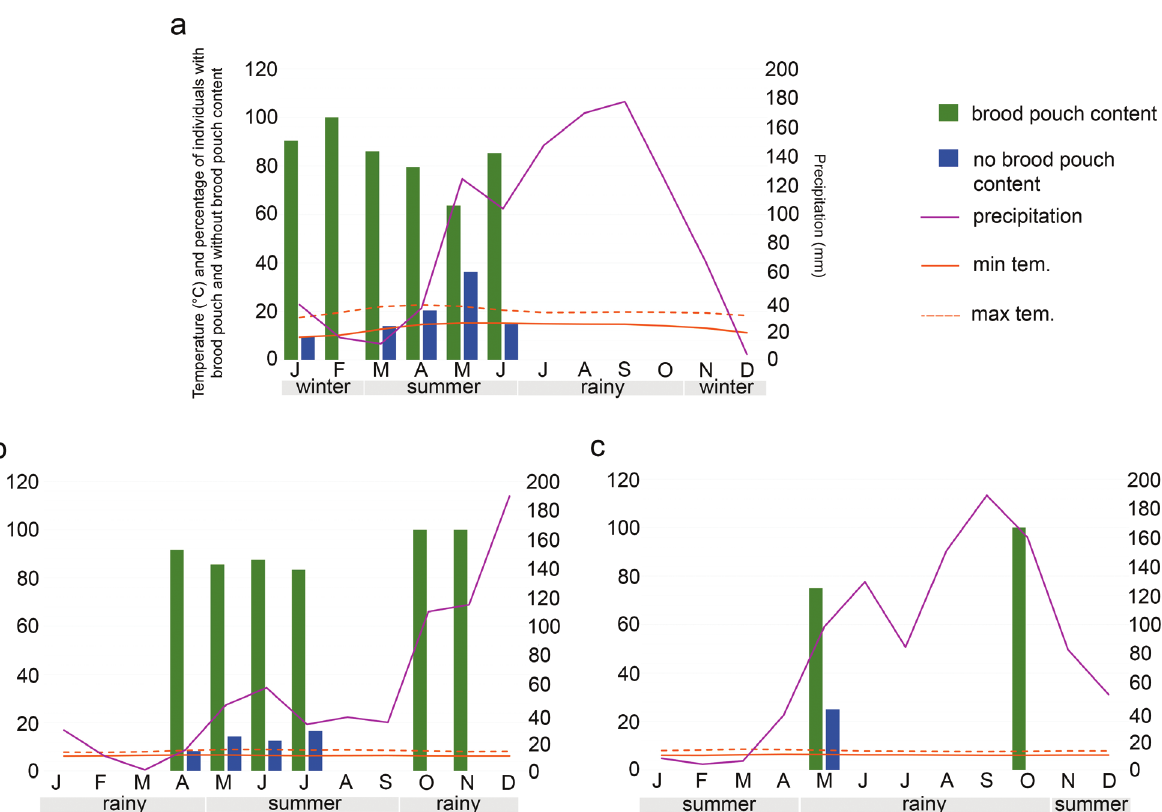
Figure 12. Proportions of gravid vs. non-gravid specimens of Tarebia granifera (Lamarck, 1816) collected in different months within a given year, plotted on climate charts for localities that are representative for different climatic regimes in Thailand. ( a ) Chi- ang Mai for inland locations; ( b ) Ko Samui for the Gulf of Thailand; ( c ) Phuket for the Andaman Sea (see also Fig. 8). For colour coding, see the inset